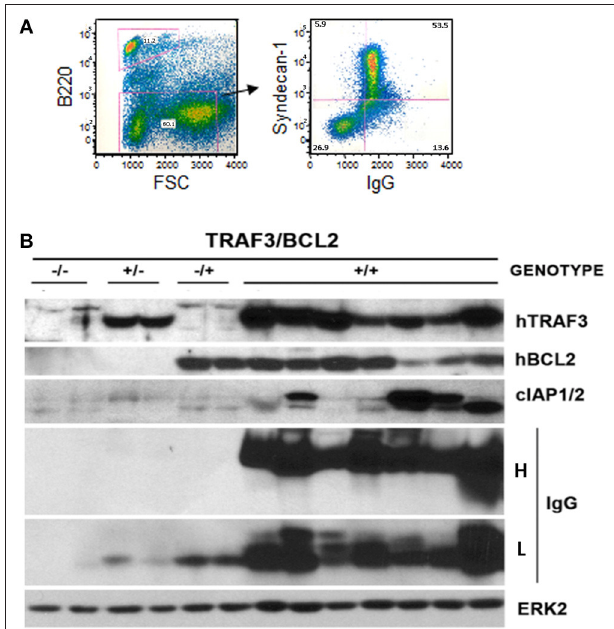
FIGURE 4 | Development of plasmablastic B cell neoplasms by TRAF3/BCL2 double-tg mice. (A) Flow cytometry analysis of a representative TRAF3/BCL2 double-tg mouse showing the expansion of an FSC high CD45B220 null lymphoid population with surface syndecan-1 (CD138) and cytosolic IgG expression. (B) Western blot analysis of lymphoid extracts (spleens and nodes) of representative examples of TRAF3/BCL2 double-tg ( + / + ) mice that have developed plasma cell neoplasms. For comparison, 2 representative examples of spleen extract from wild-type (–/–), T RAF3 -tg ( + /–), and BCL2 -tg (–/ + ) mice is also shown. The expression of human TRAF3 and BCL2, and mouse cIAP1/2 and IgG heavy H and light L chains is shown. ERK2 expression is shown as loading